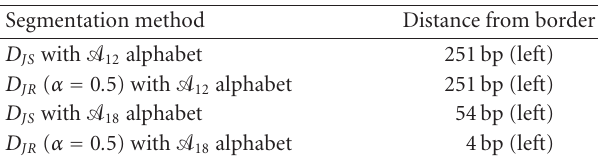
Table 4: Cuts obtained using di ff erent methods for segmentation for the same DNA sequence as in Figure